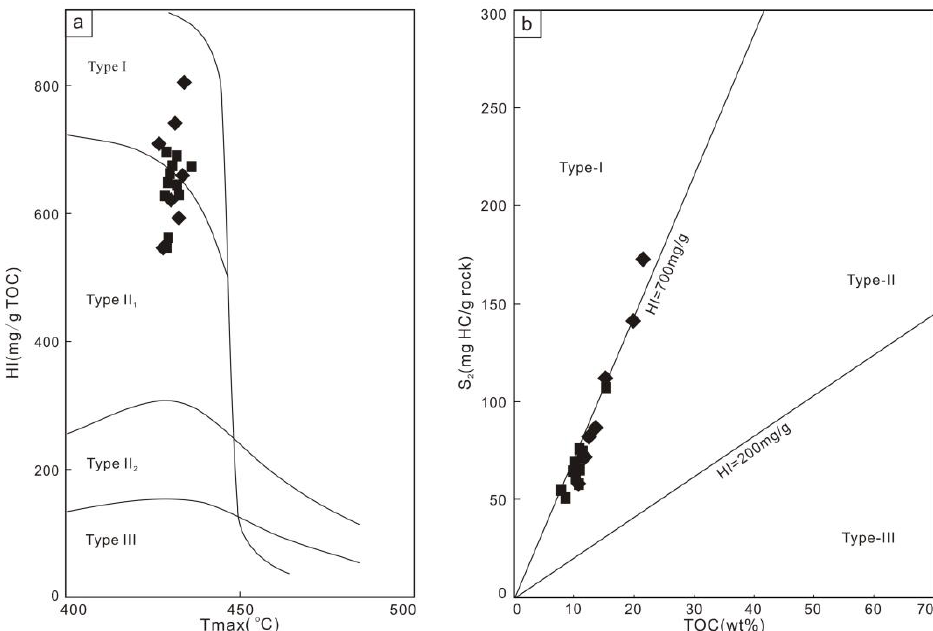
Figure 9. Organic matter type discrimination of oil shale in Youganwo Formation of Maoming Basin. ( a ): HI-Tmax diagram (after peters,1986 [67]); ( b ): S 2 -TOC diagram (after Langford and Blanc-Valleron, 1990 [68]).